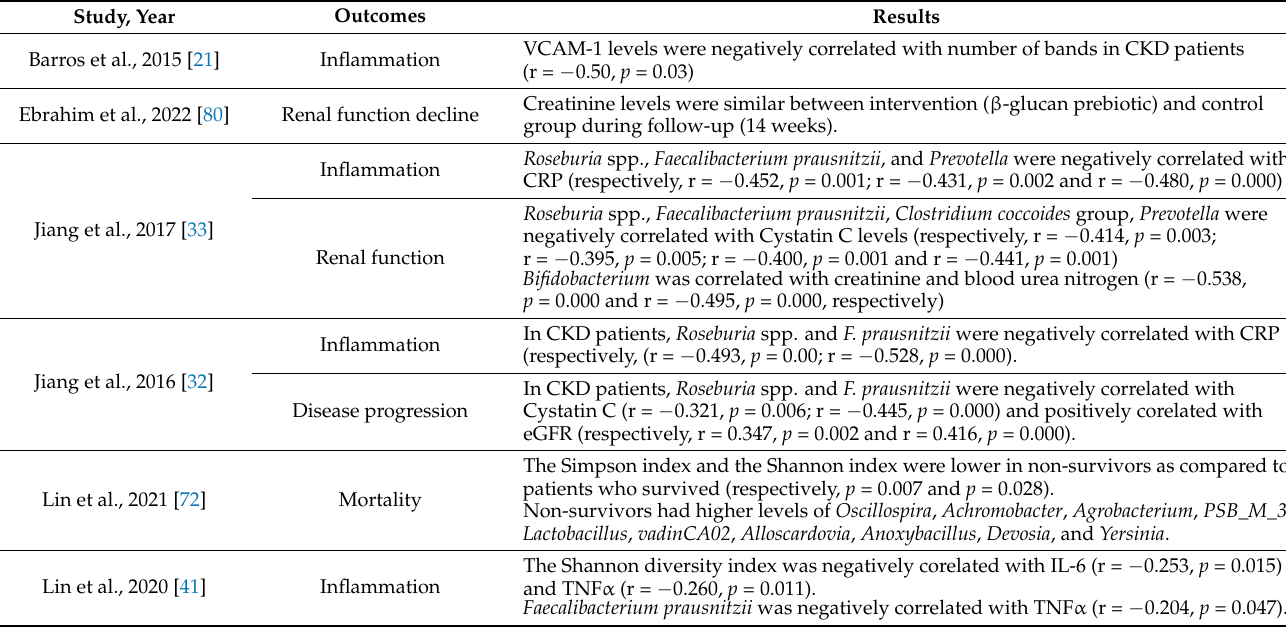
Table 2. Outcomes in CKD patients related to gut microbiota.